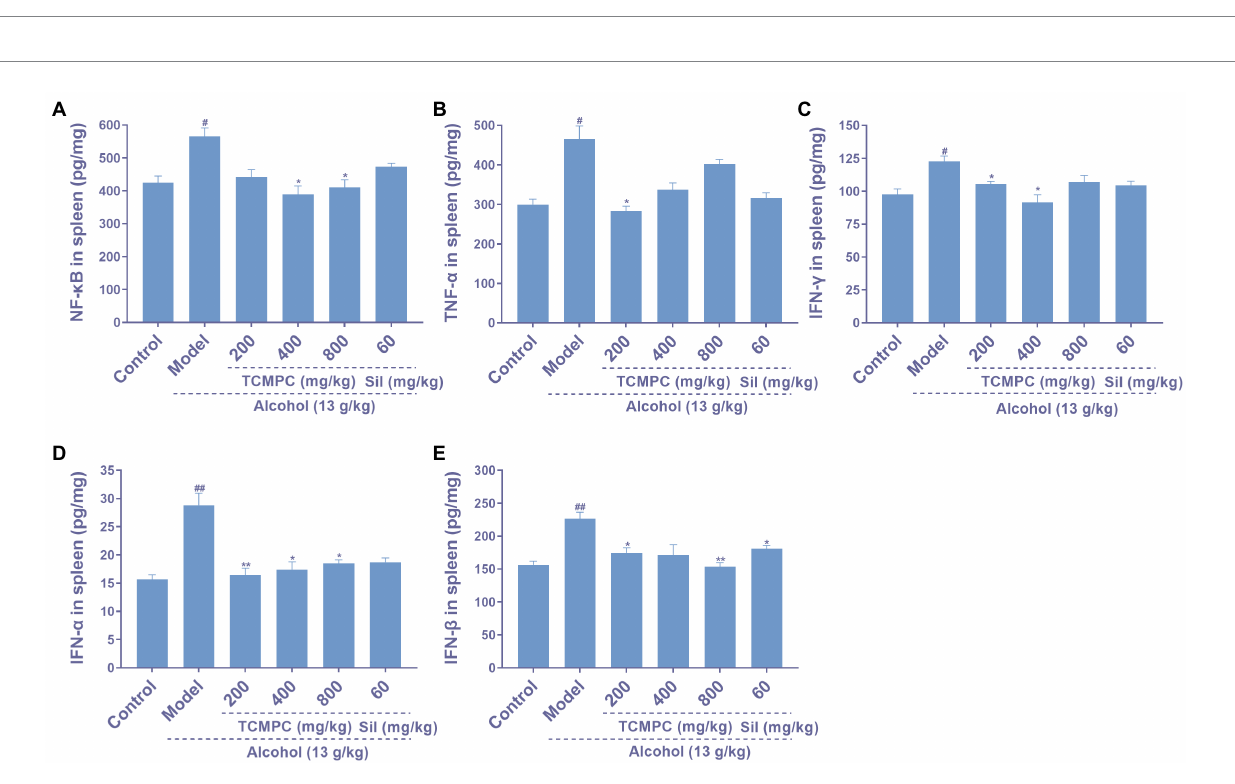
FIGURE 4 The effects of TCMPC on inflammatory cytokines levels in alcohol-induced ALI mice. The levels of NF- κ B (A) , TNF- α (B) , IFN- γ (C) , IFN- α (D) , and IFN- β (E) in spleen were detected by ELISA kit. Data are expressed as mean ± SD, n = 10. # p < 0.05, ## p < 0.01, and ### p < 0.001, versus control group. * p < 0.05, ** p < 0.01, and *** p < 0.001, versus model